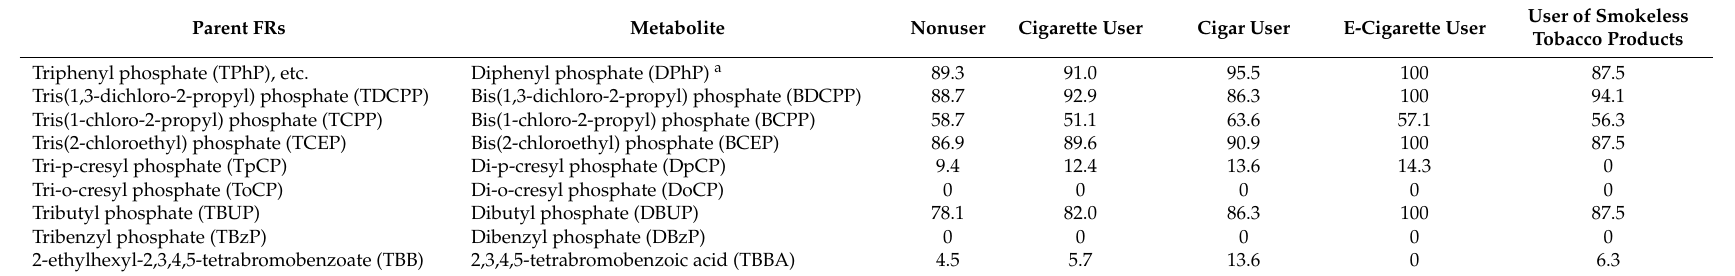
User of Smokeless Tobacco Products